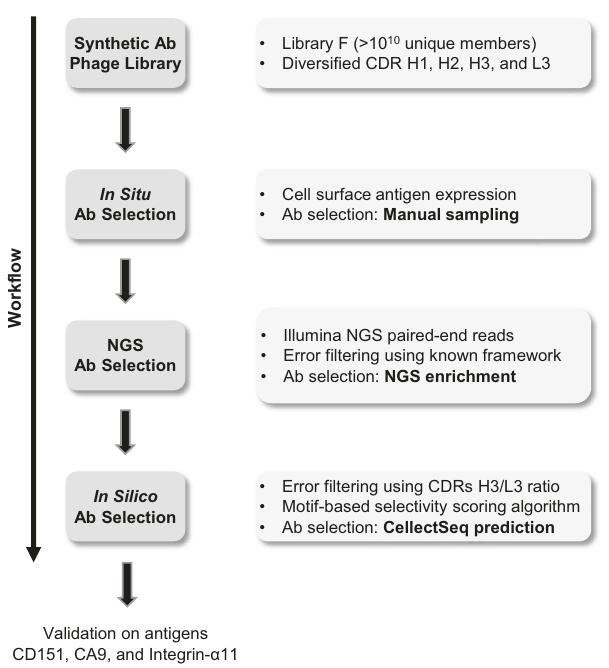
Fig. 1 Flow-chart of work fl ow for the CellectSeq process. Manual sampling: Candidate clones were selected manually from round four phage output positive pool. NGS enrichment ranking: Candidate clones were selected from NGS output based on (i) their abundance in the positive pool and (ii) their enrichment in the positive compared to the negative pool, precisely, they were taken from the top-right quadrant in Fig. 3. CellectSeq prediction: Candidate clones were predicted from NGS output using the motif-based algorithm with p values < 10 − 10